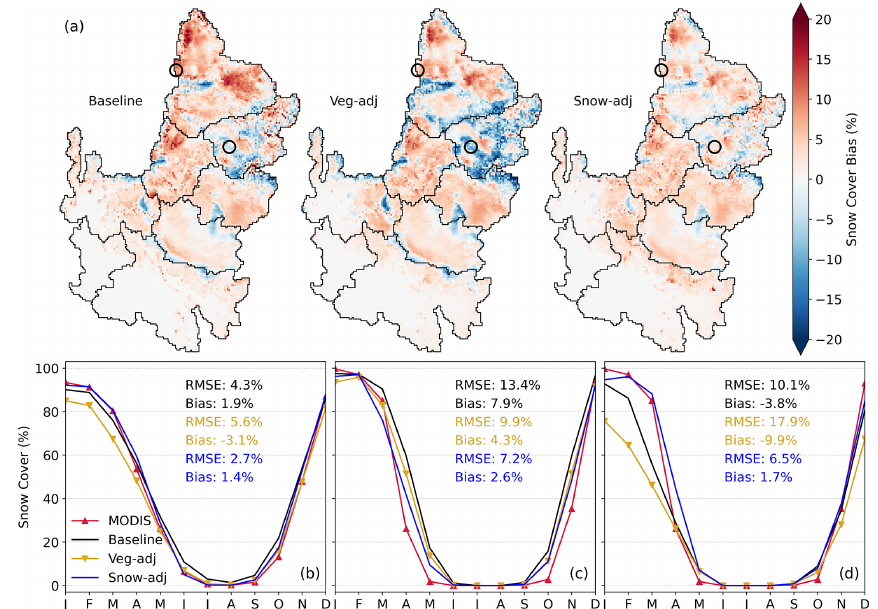
Figure 11. (a) Spatial maps of bias between mean monthly SCF (VIC minus MODIS). Circles indicate the locations of two grid cells with positive and negative bias. (b) Time series of multiyear mean monthly SCF (in %) for snow-dominated cells. RMSE and bias from monthly SCF comparisons are reported. (c, d) Same as panel (b) but for sites with positive and negative bias, respectively.